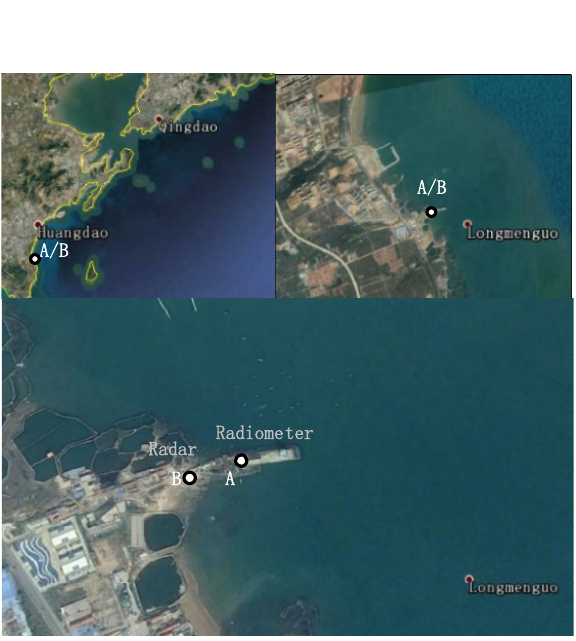
Figure 1. The location of the radiometer used in this study. Point A is located near Qingdao, Shandong province, China. The ground-based microwave radiometer was set up at point A for observation, facing the open ocean in the southwest direction. There are no islands within 300 km ahead in the observation direction of the radiometer. The images in this figure were provided by google earth. In Equation (9), the integral range of the numerator is within the main beam, and the integral range of the denominator is the solid angle of 4 π . F n ( θ , ϕ ) is the antenna pattern, θ is the elevation angle, ϕ is the azimuth